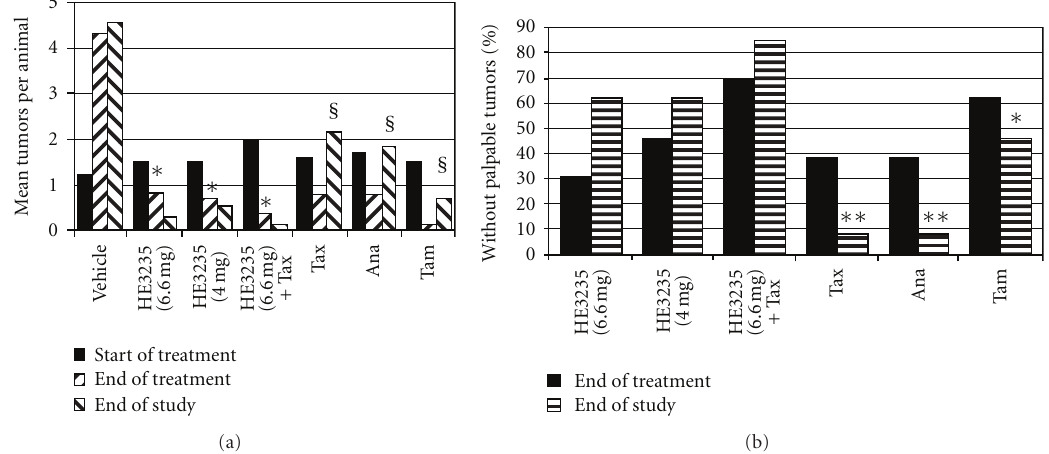
Figure 3: Tumor Incidence. Seven-week-old female Lewis rats were treated with a single IP injection of 50mg/kg MNU. Tumors developed for 90 days, prior to treatment ( n = 13) for 28 days with (1) cyclodextrin vehicle daily, (2) 6.6mg HE3235 daily, (3) 4mg HE3235 daily, (4) 6.6mg HE3235 daily + 1.5mg docetaxel weekly, (5) 1.5mg docetaxel weekly, (6) 2.5mg anastrazole daily, and (7) 0.25mg tamoxifen weekly. HE3235 as a monotherapy or in combination with docetaxel, was more e ff ective at decreasing the number of tumors and rendering animals disease-free, than comparator therapies. (a) the e ff ect of treatment on the average number of tumors per animal. ∗ P start versus end of treatment = .0008 (6.6mg HE3235), .0007 (4mg HE3235), and < .0001 (HE3235+Tax); § P end of treatment versus end of study = .0003 (Tax), .0016 (Ana), < .0001 (Tam). (b) the percentage of rats in each group without palpable tumors. (there were no disease-free animals in the vehicle group, not plotted.). ∗∗ P versus HE3235 + Tax, < .0001, ∗∗ P versus HE3235 + Tax, .0405. Tax, docetaxel; Ana, anastrozole; Tam, tamoxifen.